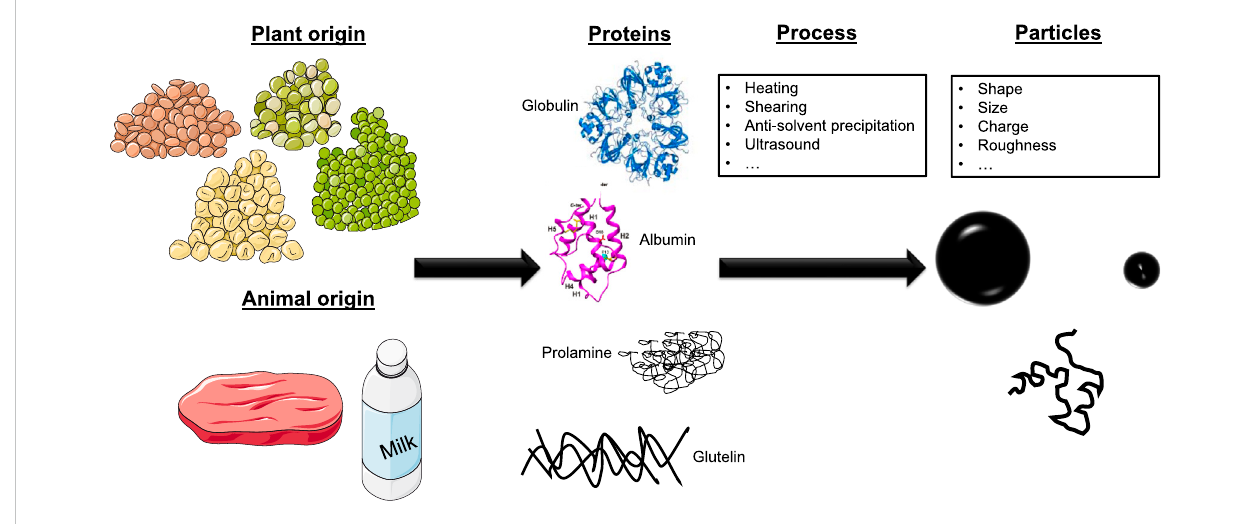
FIGURE 2 Schematic summarizing the origin of the proteins (animal or plant), the main proteins and the process used to produce the protein particles with different characteristics. The fi gure was partly generated using Servier Medical Art, provided by Servier, licensed under a creative commons attribution 3.0 unported